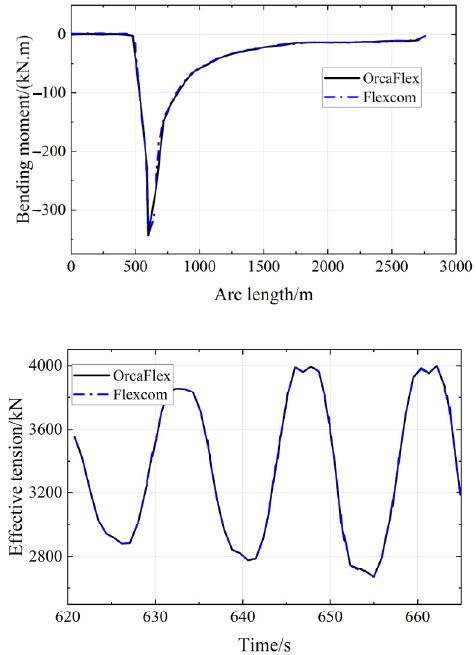
Figure 7. The bending moment and the time history of the effective tension.